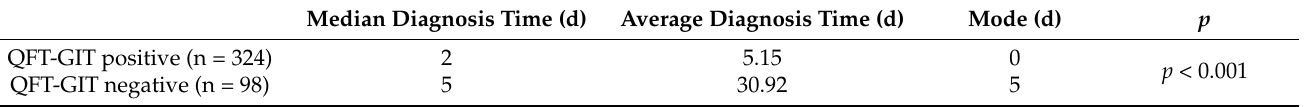
Table 1. Positive QFT-GIT results greatly shortened the time to diagnose TB. n: number. d: diagnosis time. Median Diagnosis Time